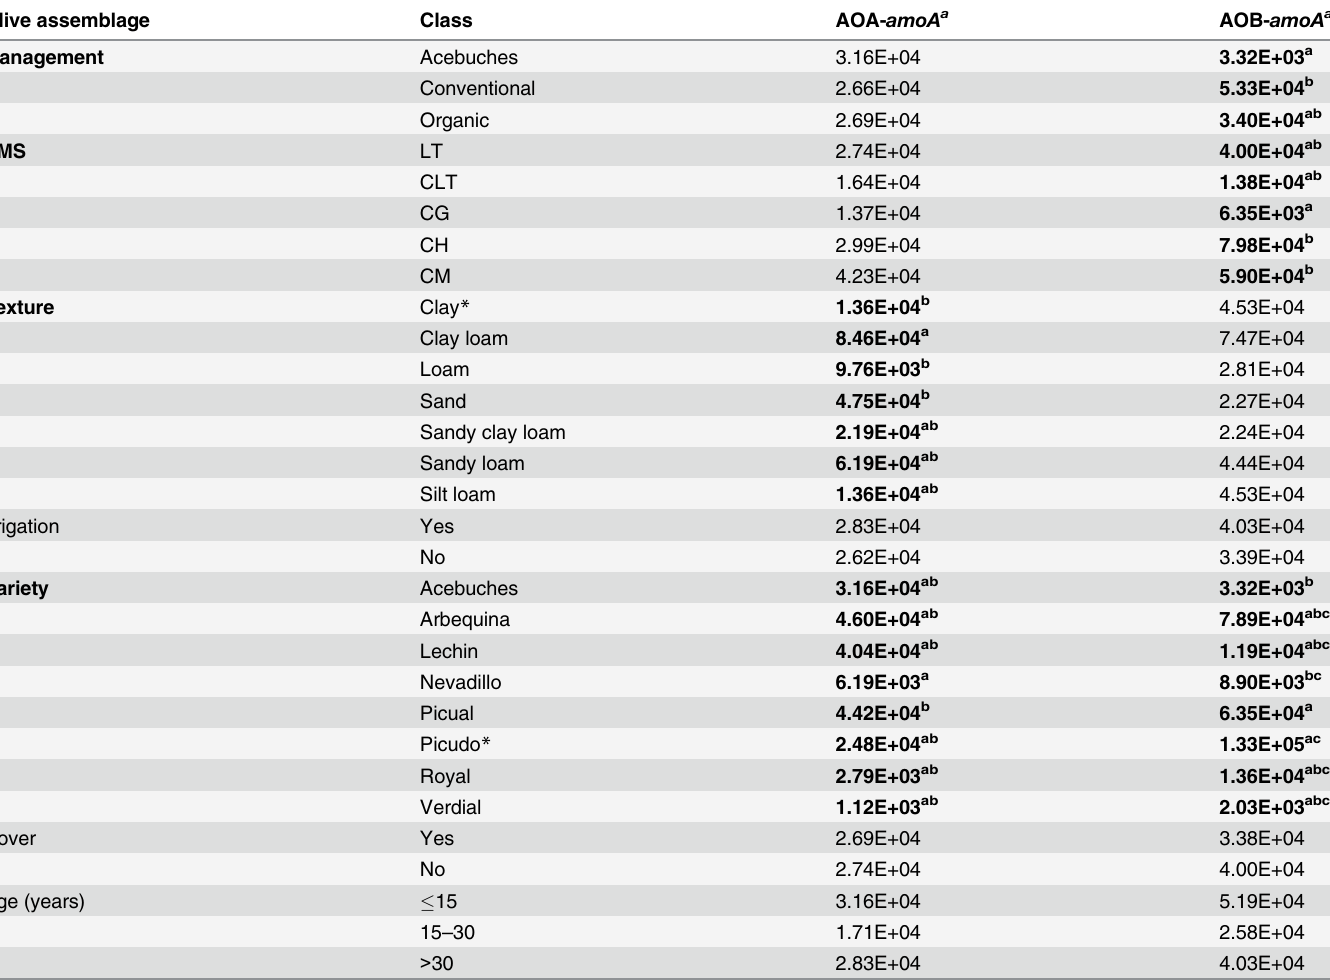
Table 4. Comparison of mean amoA genes concentrations for AOA and AOB assemblages in the olive trees rhizosphere. Olive